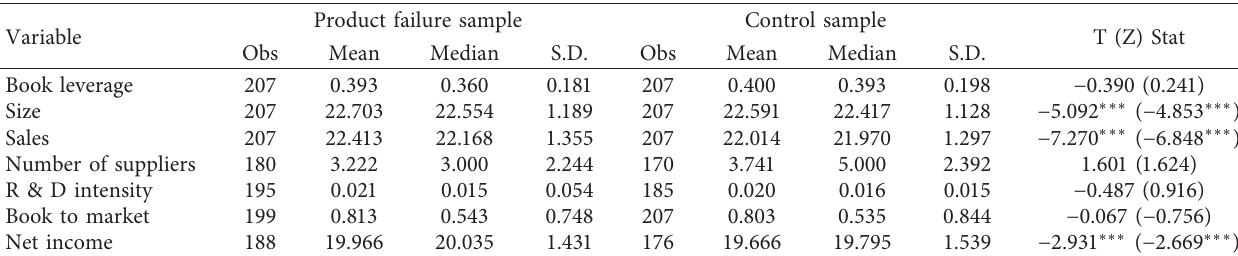
Table 2: Univariate comparisons between product failure samples and control